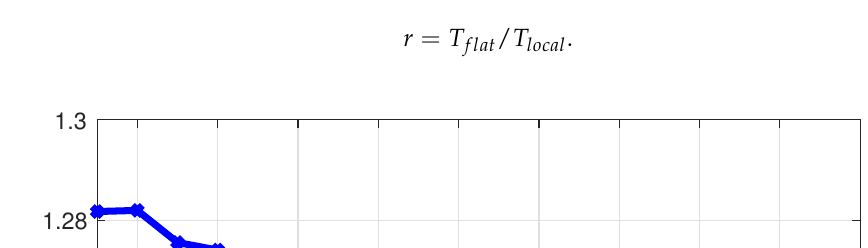
Figure 9. Computational time and the normalized task planning cost w.r.t the number of satellite clusters in the static case. The total number of satellites and objects is 20 and 200, respectively.